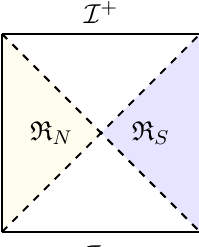
Figure 1 . Penrose diagram of de Sitter spacetime with two Rindler observers R N and R S . I ± corresponds to the past and future conformal infinities of the global